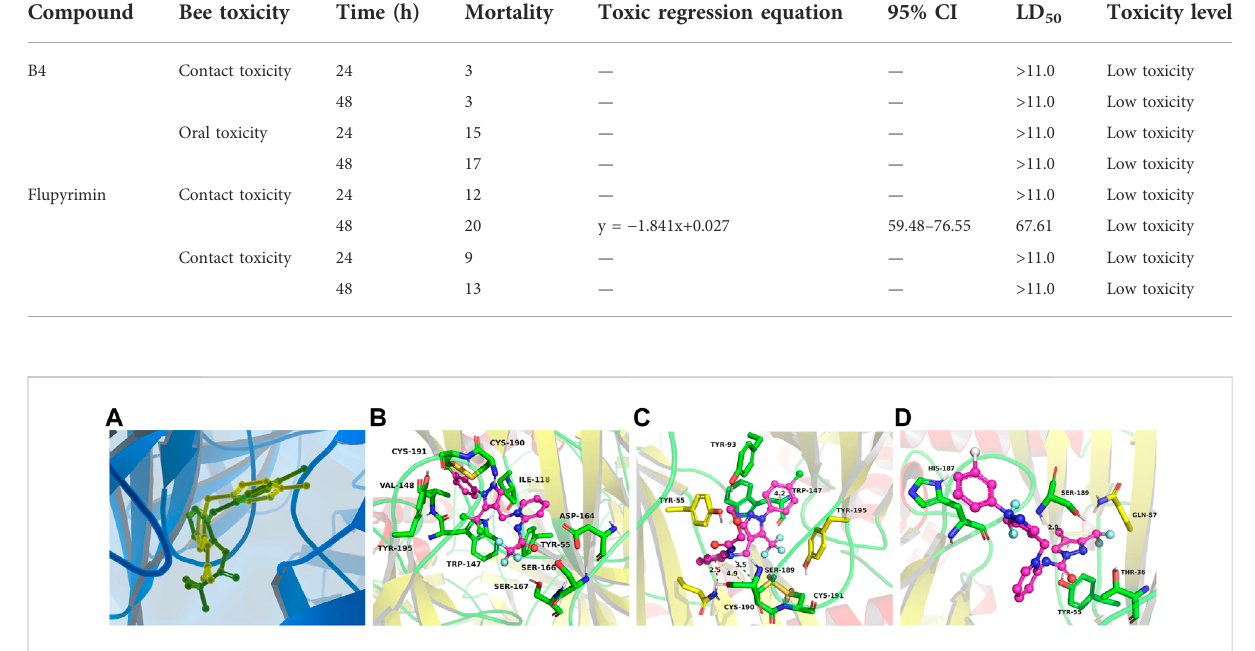
FIGURE 6 Simulated binding modes of compounds imidacloprid (yellow) and FLP (green) (A) , A3 (B) , B4 (C) , and D6 (D) with AChBP (PDB: 3c79).